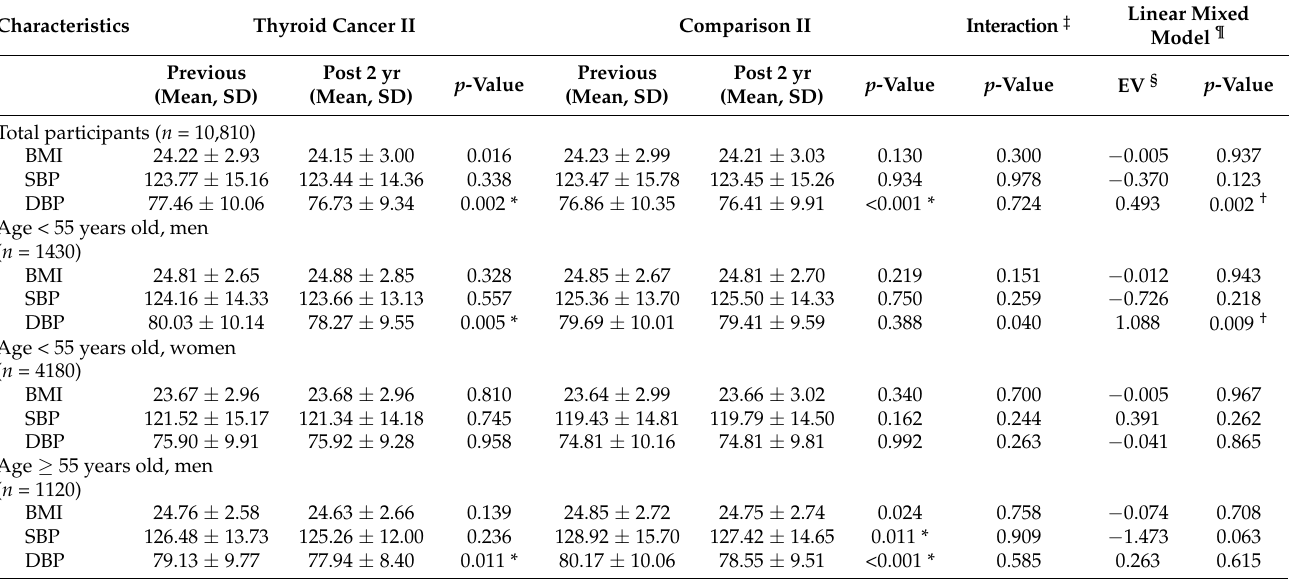
Table 3. Difference in mean values of BMI and blood pressure between pre and 2-year post thyroid cancer in study II according to age and